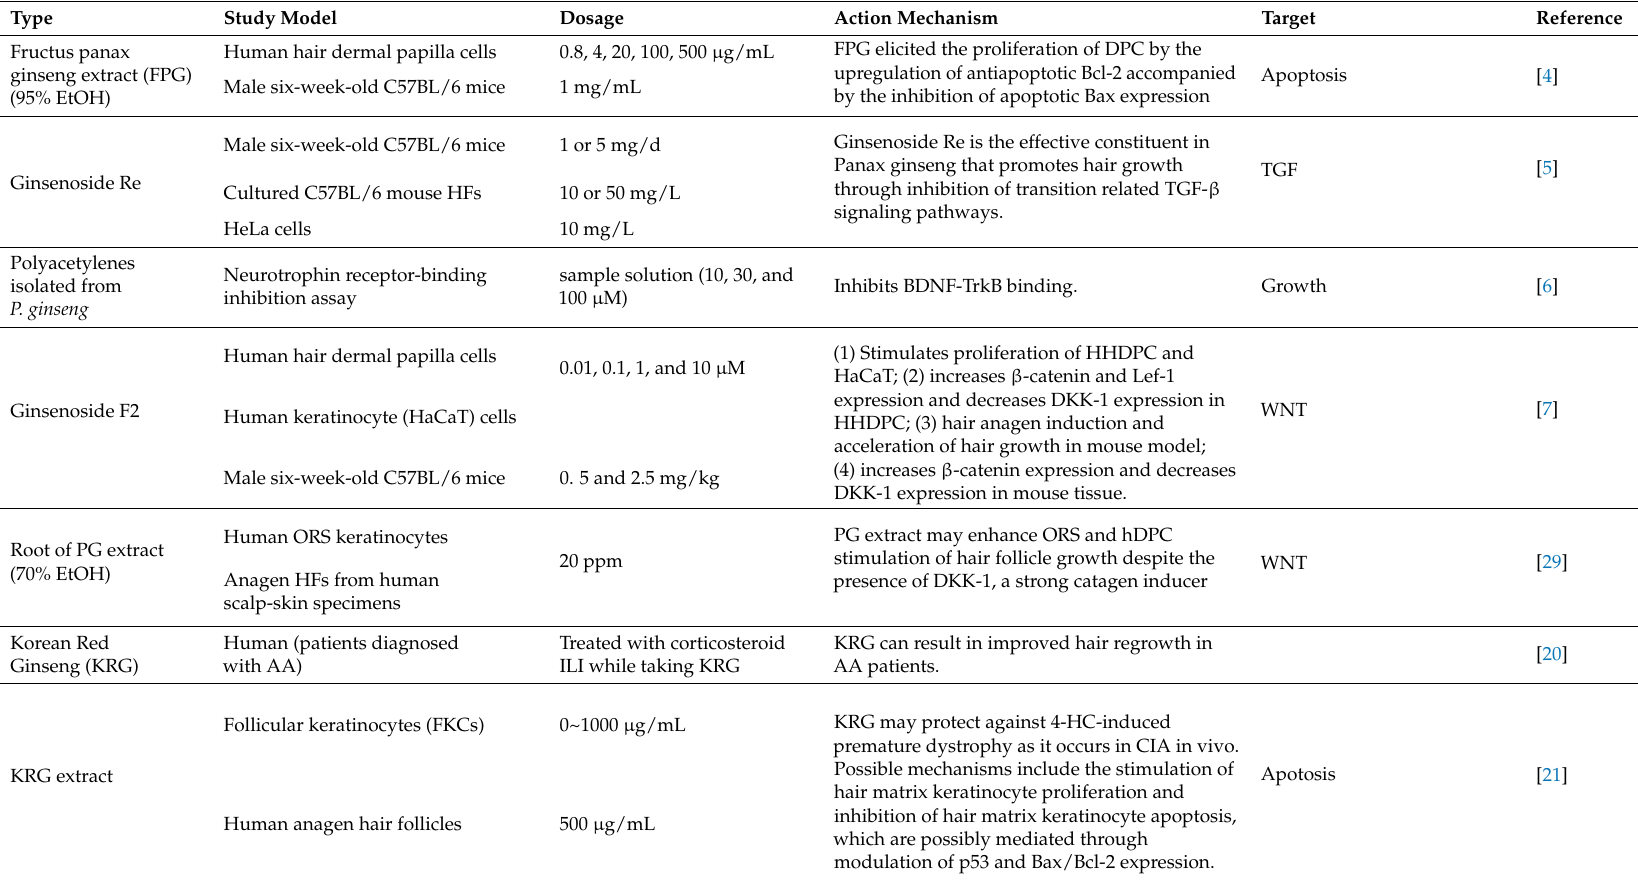
Table 1. Molecular mechanisms underlying hair-proliferative and antiapoptosis-inducing activity of